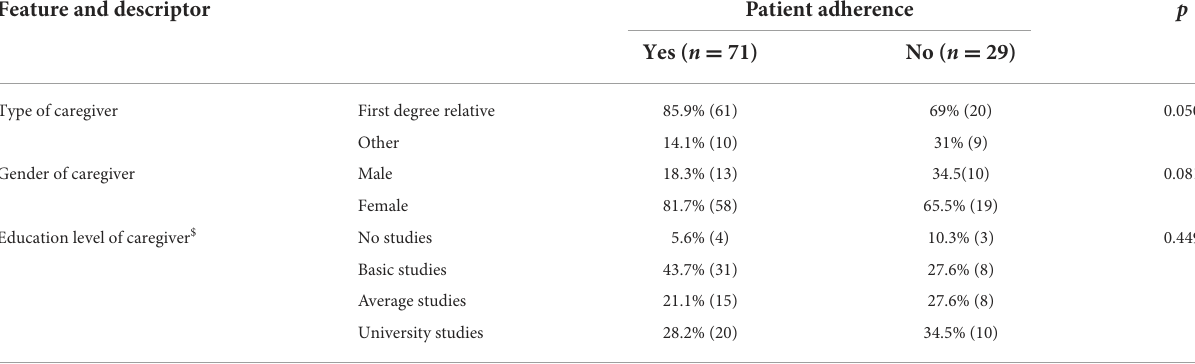
TABLE 2 Prevalence of the adherence and non-adherence groups according to the results of the Morisky-Green-Levine test related to the features of the caregiver. Feature and